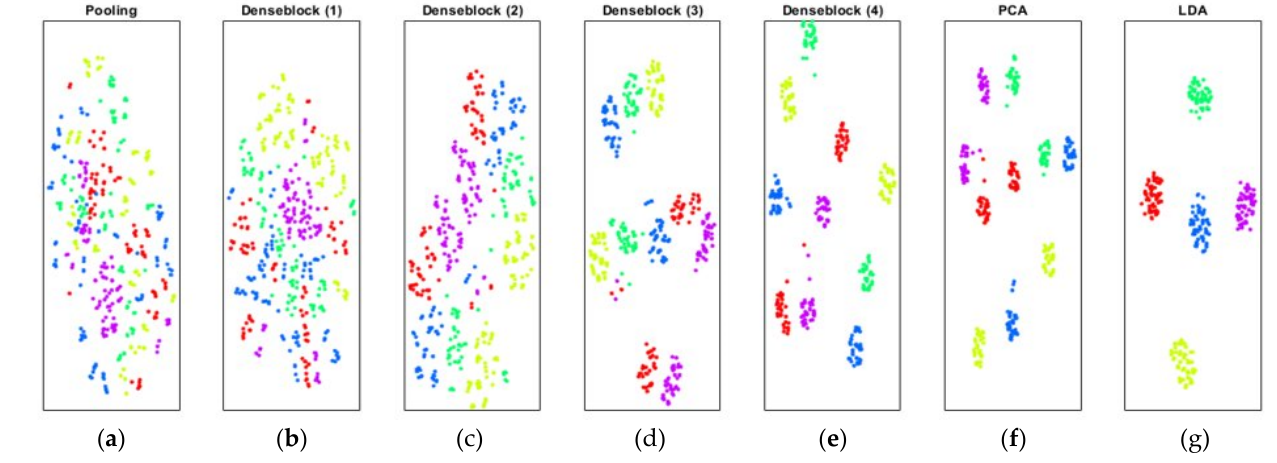
Figure 17. Visualization using t-SNE plots of the features extracted from various layers of the LDA-CNN model: ( a ) Pooling 1; ( b ) Denseblock 1; ( c ) Denseblock 2; ( d ) Denseblock 3; ( e ) Denseblock 4; (f ) PCA and ( g ) LDA for five classes of the VISOB dataset.